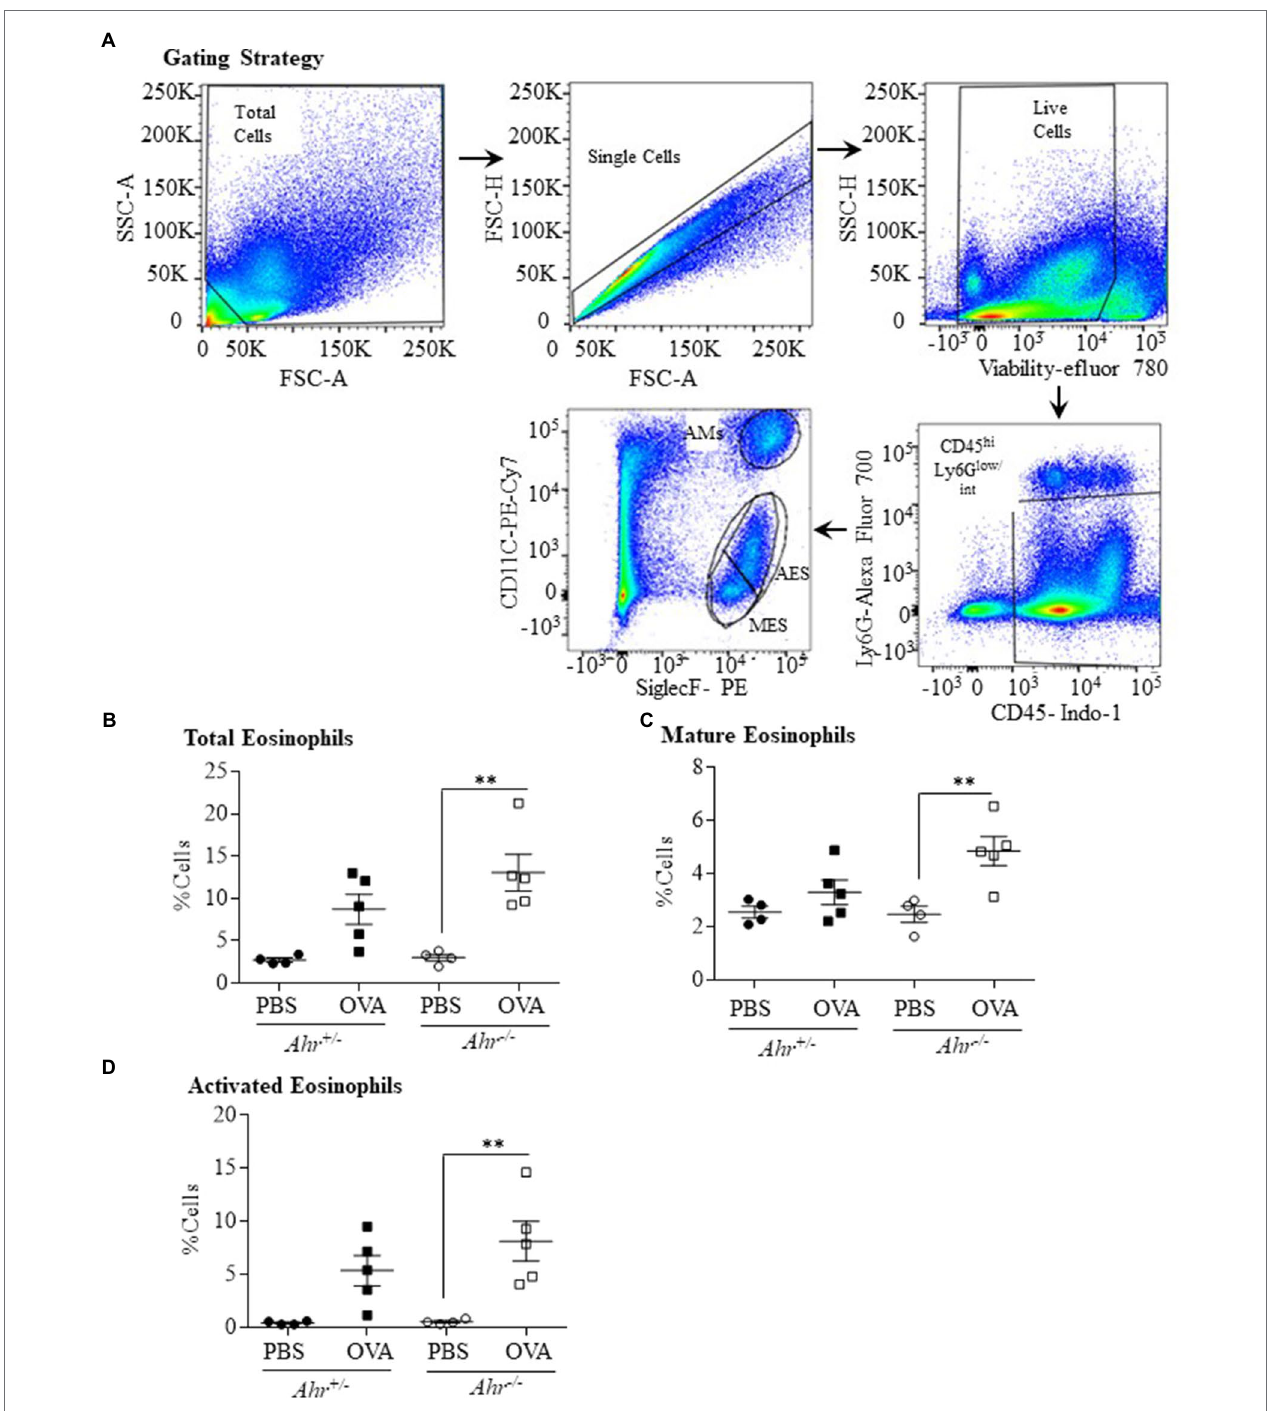
FIGURE 3 | Aryl hydrocarbon receptor expression decreases the percentage of eosinophils in the lung parenchyma after exposure to OVA. (A) Gating Strategy – the gating strategy utilized for flow cytometry to quantify mature vs. activated eosinophils in lungs tissue is shown. The percentage of total (B) , mature (C) , and activated (D) eosinophils in lung tissue was significantly increased in Ahr − / − mice exposed to OVA compared with PBS control mice (** p = 0.0028; 0.0088, and 0.0065, respectively). Results are expressed as the mean ± SEM; values for individual mice are